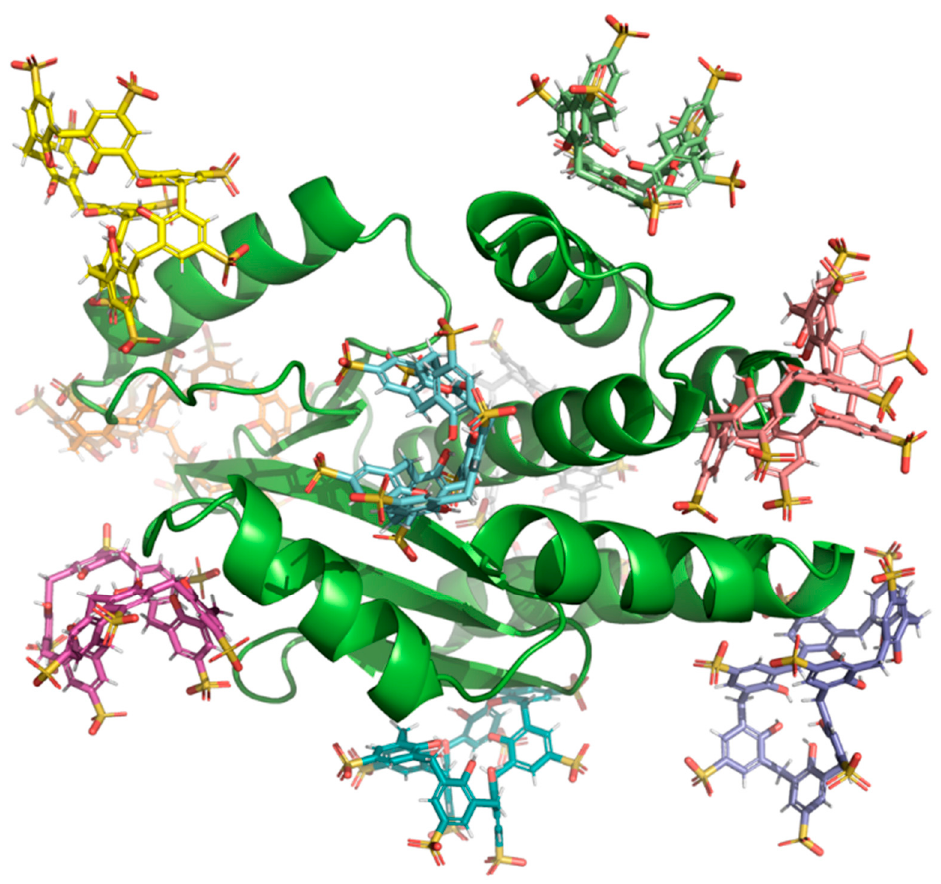
Figure 5. Molecular interactions between PA endonuclease and SC8a for the top poses predicted by blind docking.